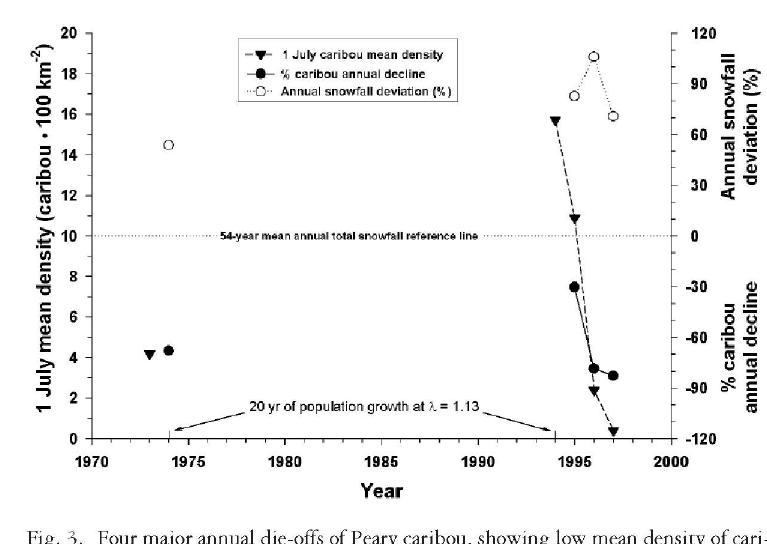
Fig. 3. Four major annual die-offs of Peary caribou, showing low mean density of cari¬ bou at start of die-off period, relative severity of total snowfall (1 Sep-21 Jun) expressed as the deviation from the 55-yr mean (in caribou-years, 1 Jul-30 Jun, 1947/48-2001/02) and the resultant percentage decline in the population dur¬ ing each die-off, Bathurst Island complex, western Queen Elizabeth Islands, Canadian High